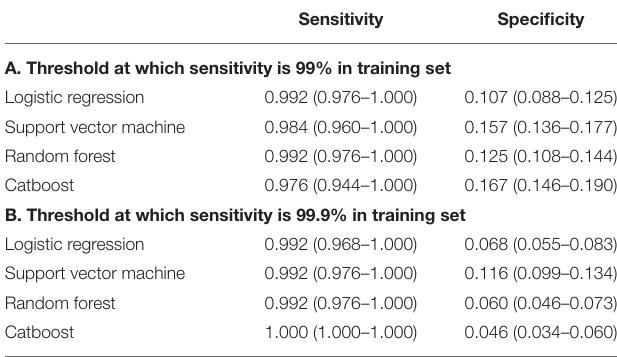
TABLE 2 | Sensitivity and specificity of the classification models in the independent test